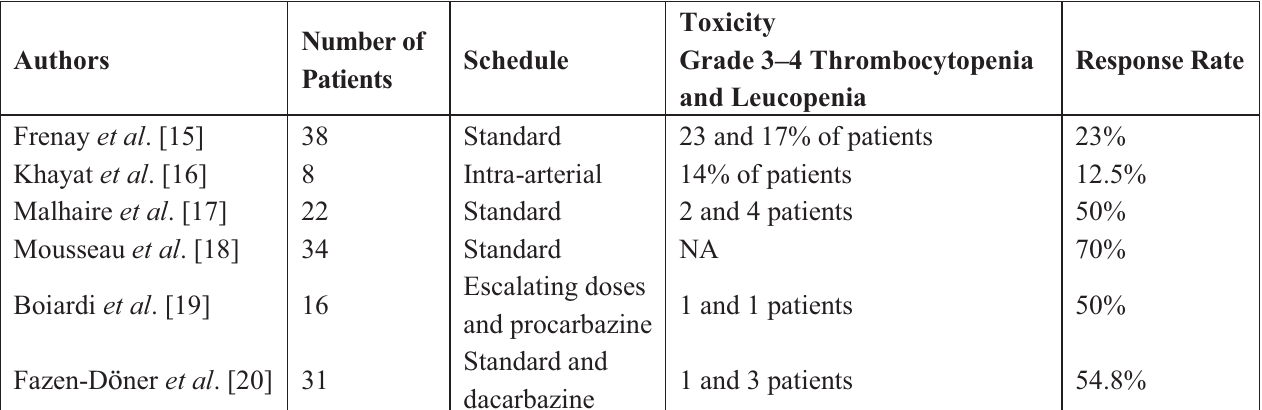
Table 1. Fotemustine before temozolomide